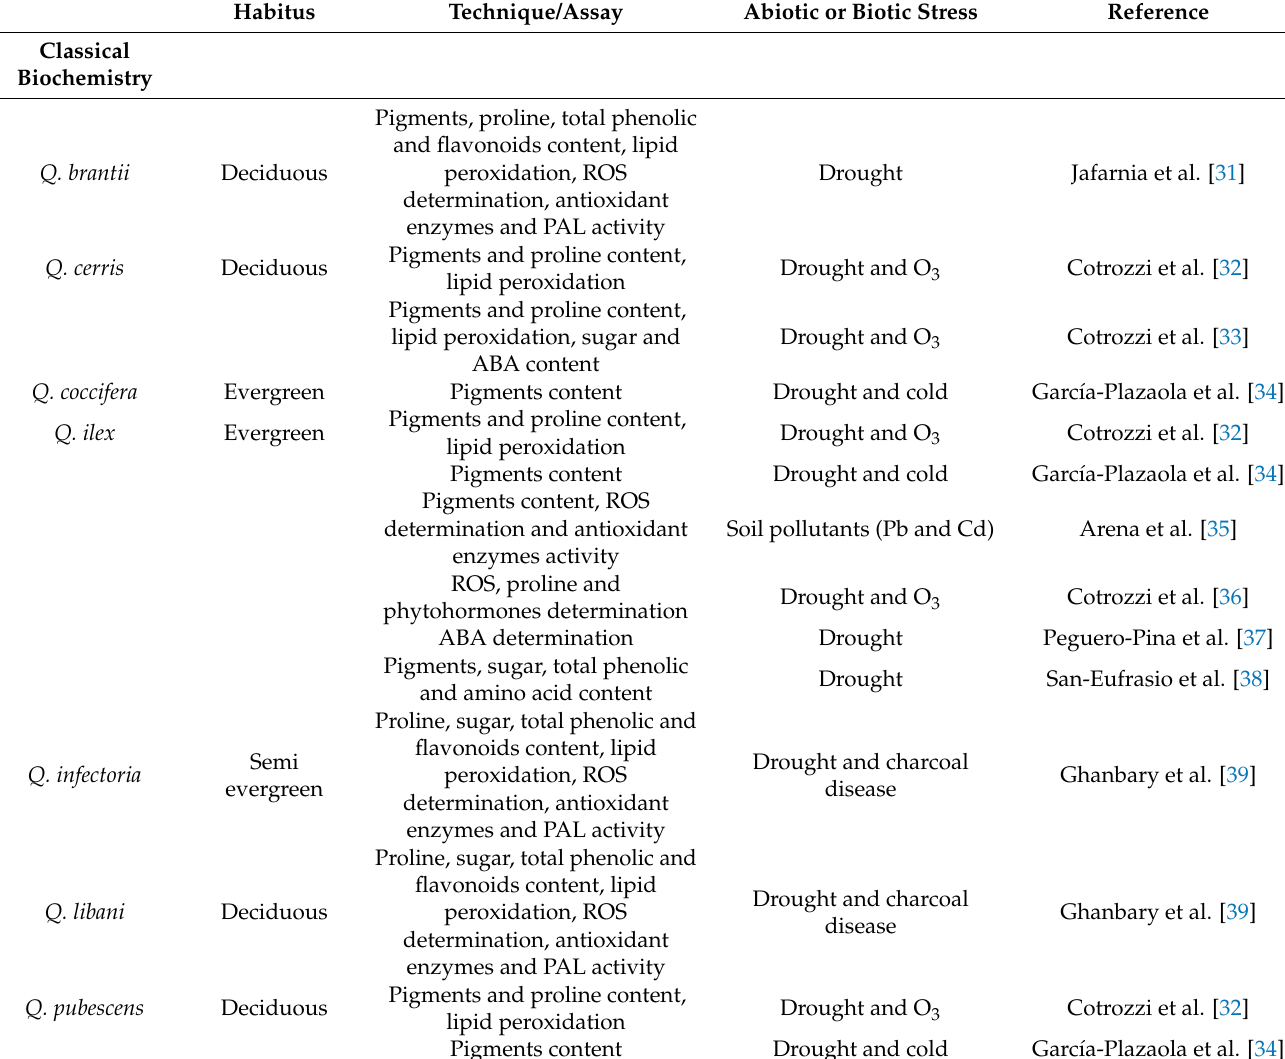
Table 1. Molecular stress studies carried out on the genus Quercus in the last 5 years. This table also includes those studies carried out at genomic and proteomic levels that are not under stress conditions to indicate the current status in this genus.